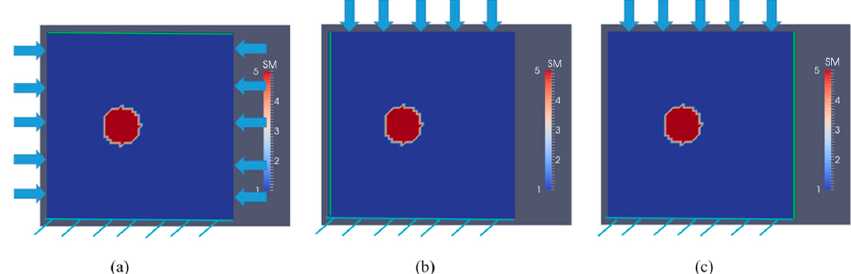
Figure 1. The problem domain with a stiff inclusion surrounded by a soft background. The arrows indicate the indentation locations, and the green line represents the side of known or measured displacements. ( a ) the indentations are sequentially applied pairwise at both lateral sides (net force is zero), and we utilize boundary displacements on the top edge as measured data; ( b ) the indentation is applied on the top edge, and we utilize boundary displacements on the left edge as measured data; ( c ) the indentation is applied on the top edge, and we utilize boundary displacements on the right edge as measured data (unit in the scale bar: 10 kPa). Note: “SM” stands for shear modulus.